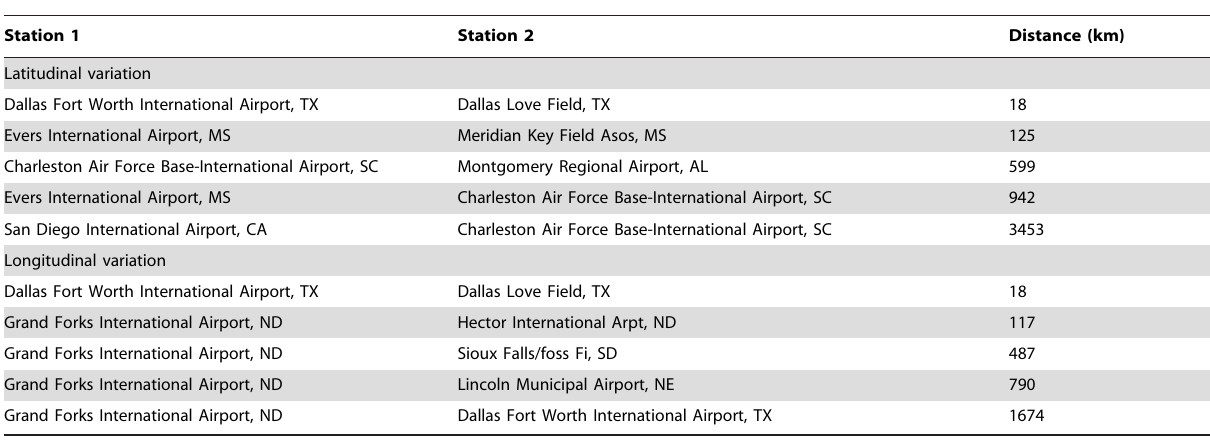
Table 1. US Weather stations used in the